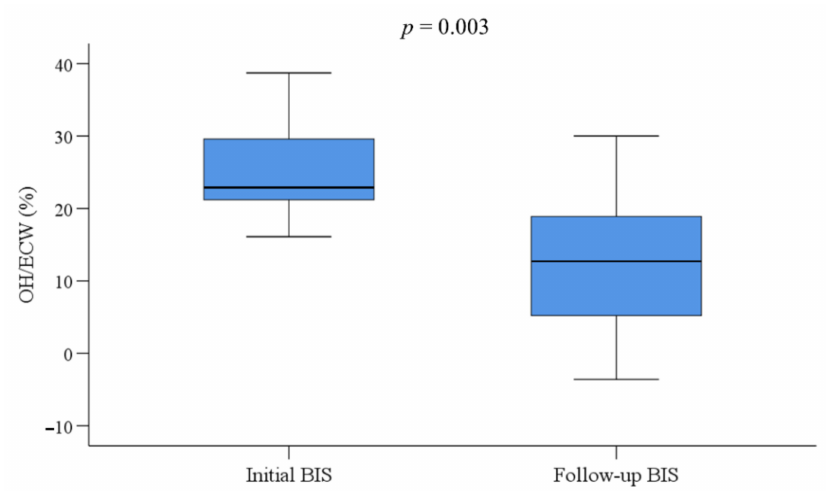
Figure 1. Change in the proportional overhydration to extracellular water (OH/ECW, %) between baseline and follow-up bioimpedance spectroscopy (BIS) ( n = 13). Statistical analysis was performed using Wilcoxon signed rank sum test.